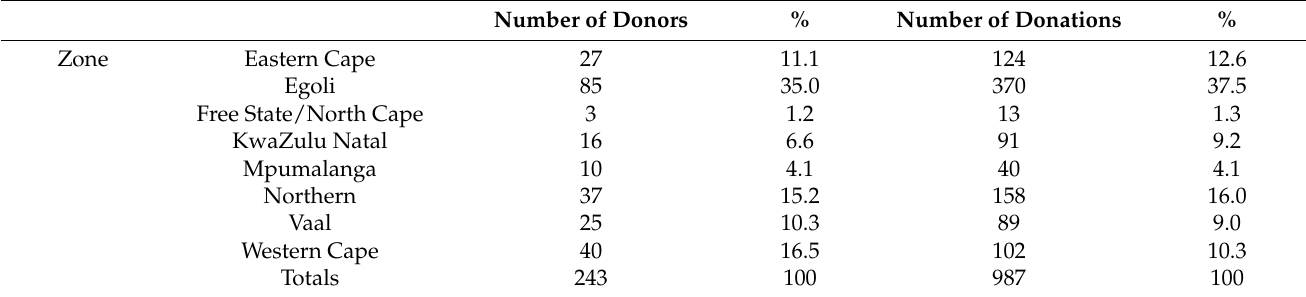
Table 3. Location of donors and total collections.